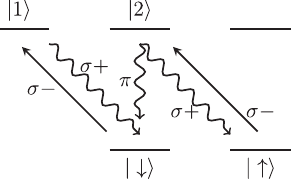
FIG. 7. Schematic illustration of the atomic-level structure. The atoms are illuminated by an incident light with the σ − polari- zation, exciting atoms j ↑ i → j 2 i and j ↓ i → j 1 i . The state j 1 i decays to j ↓ i , while the state j 2 i can decay either to j ↑ i or to j ↓ i